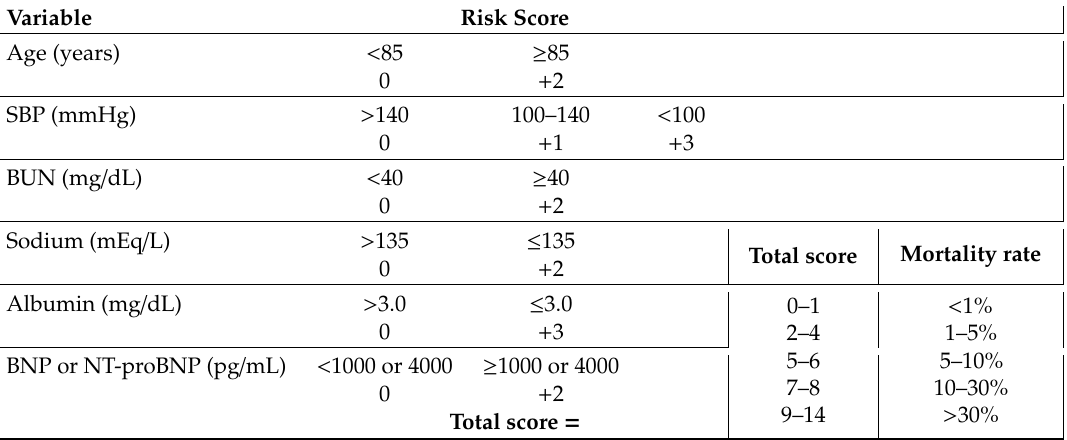
Table 4. A chart to calculate the integer risk score for each